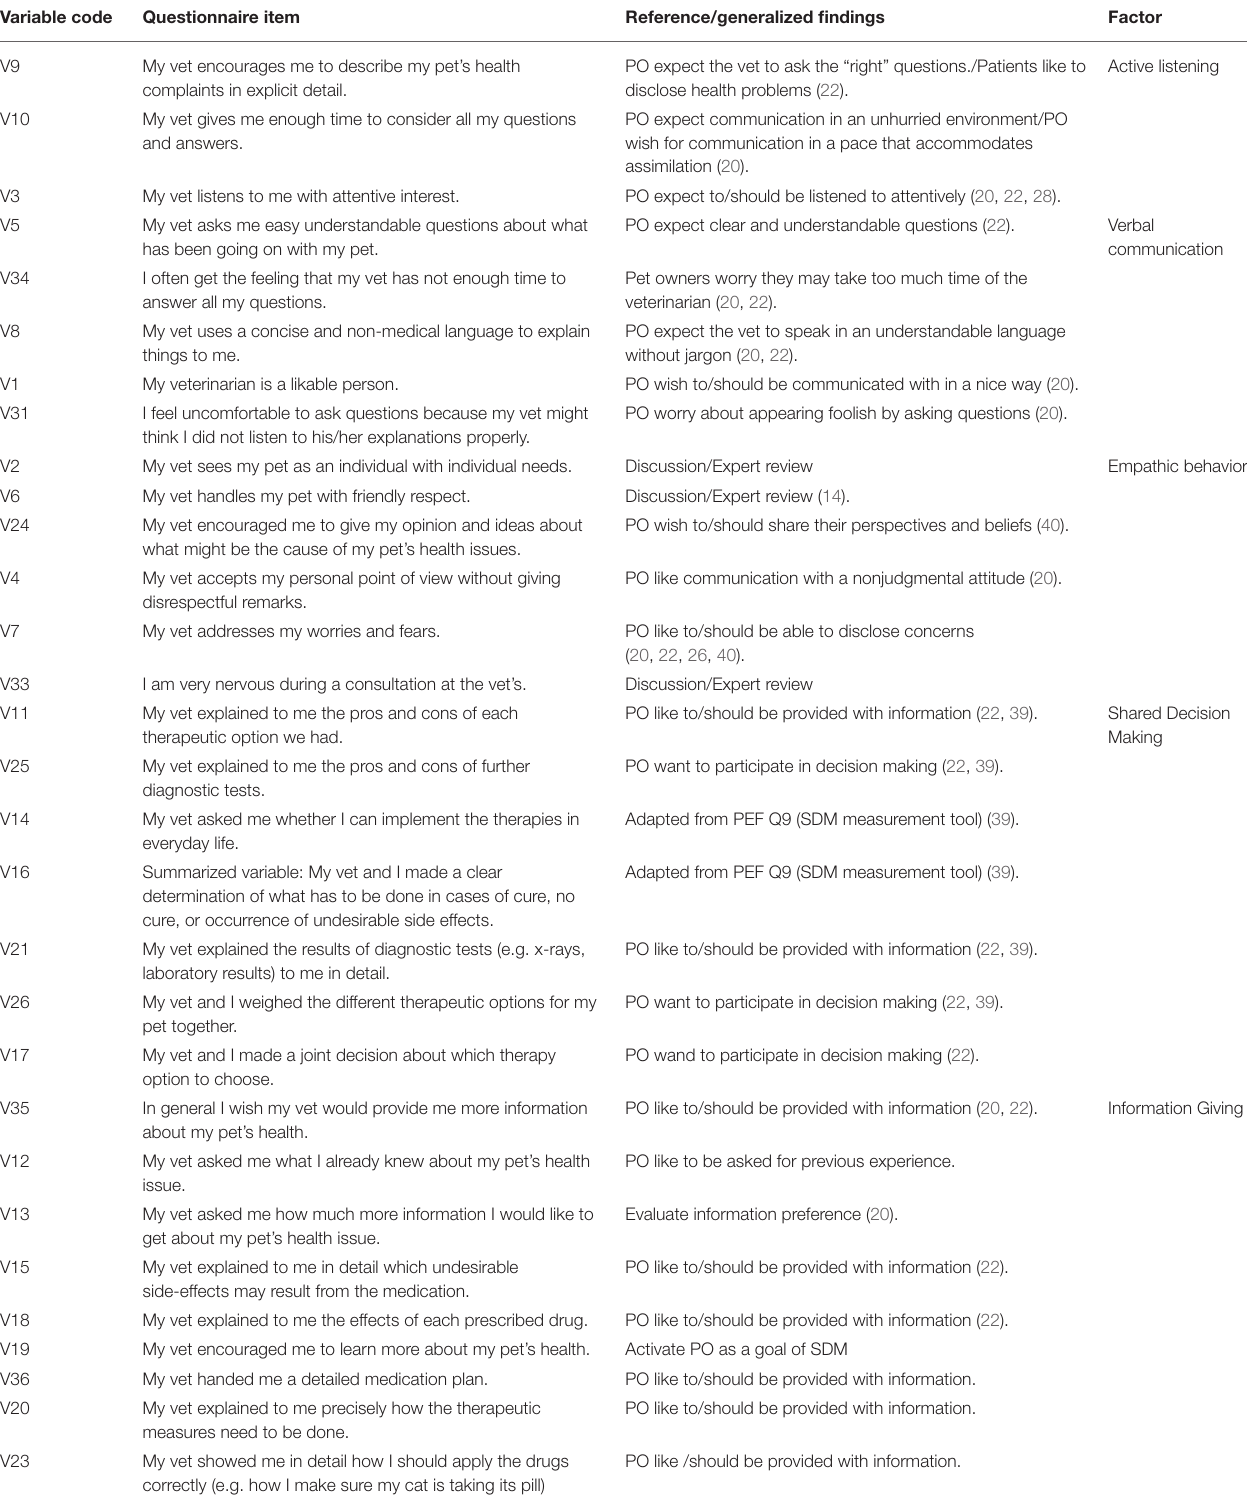
TABLE 1 | Questionnaire items (translated to English) and corresponding references for a survey on German pet owners’ perception of communication with their veterinarian. Variable code Questionnaire